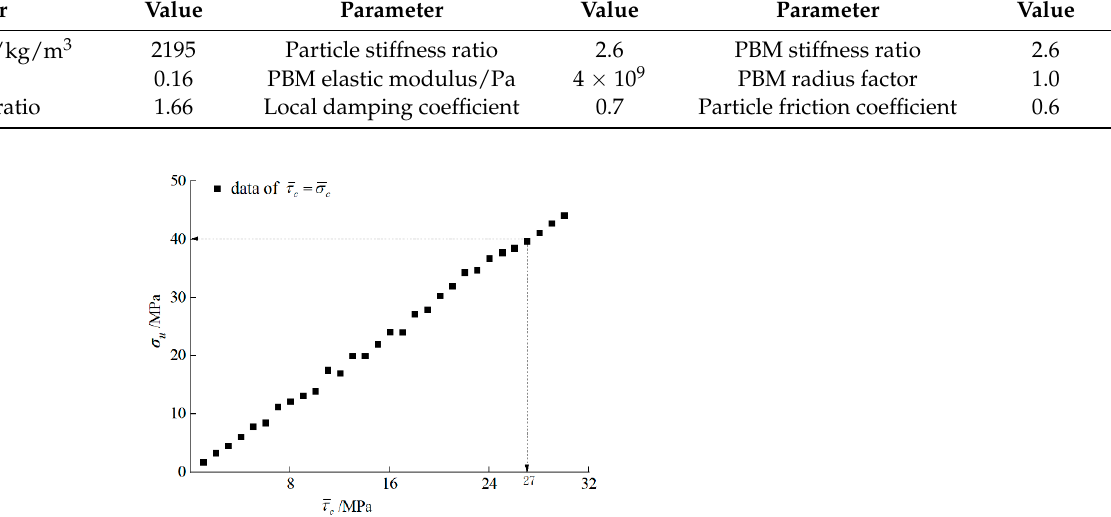
Figure 1. The relationship between the equivalence bond strength and peak strength. Table 1. Main micro-parameters of the model.